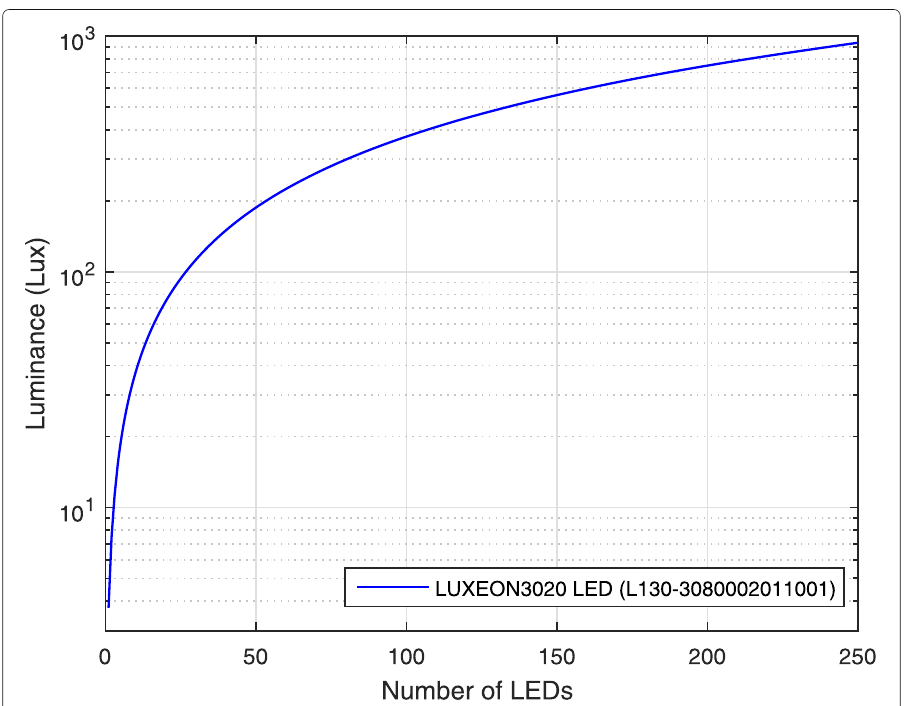
Fig. 2 Luminance at 2.25 m right below the luminary. The luminance level on the task area according to the number of